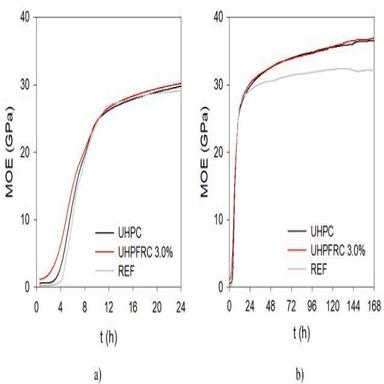
MOE evolution since casting: a) up to 24 h; up to 168 h).